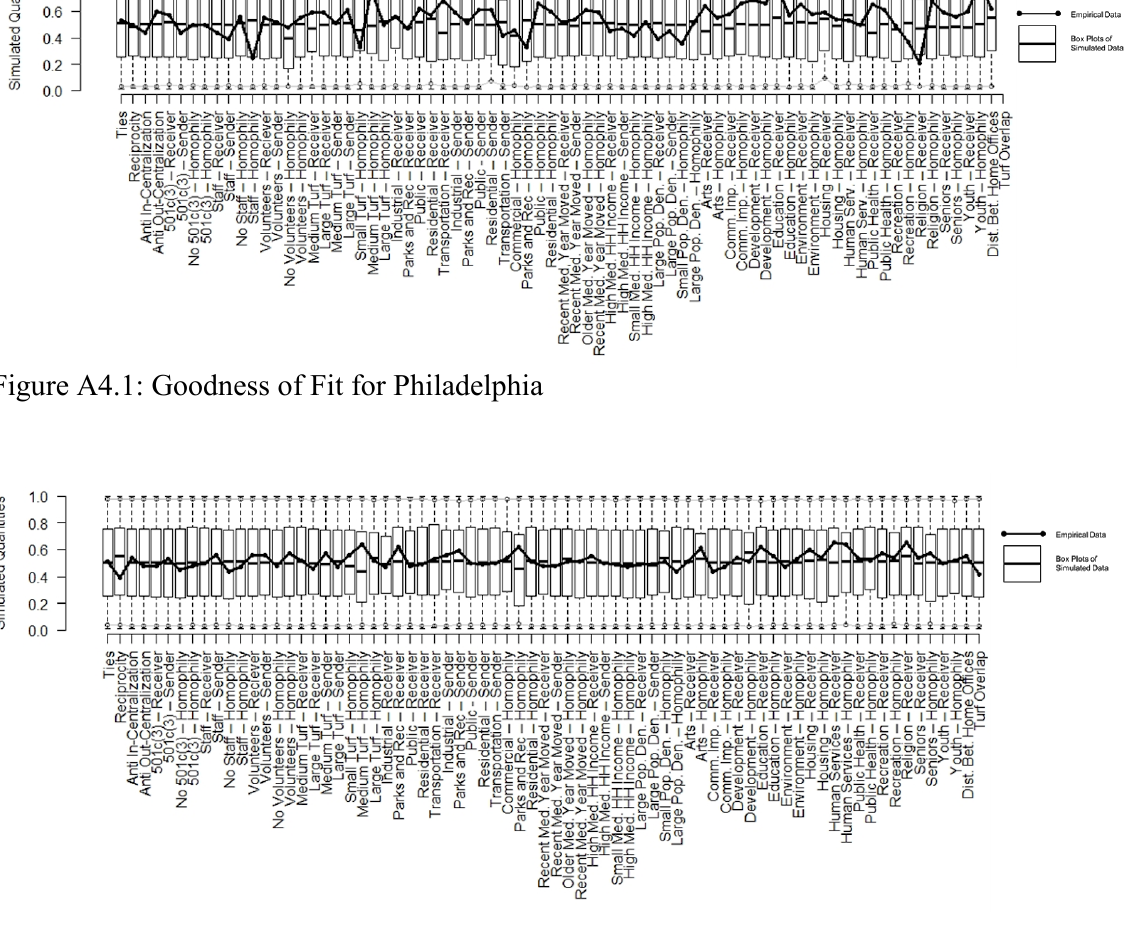
Figure A4.2: Goodness of Fit for New